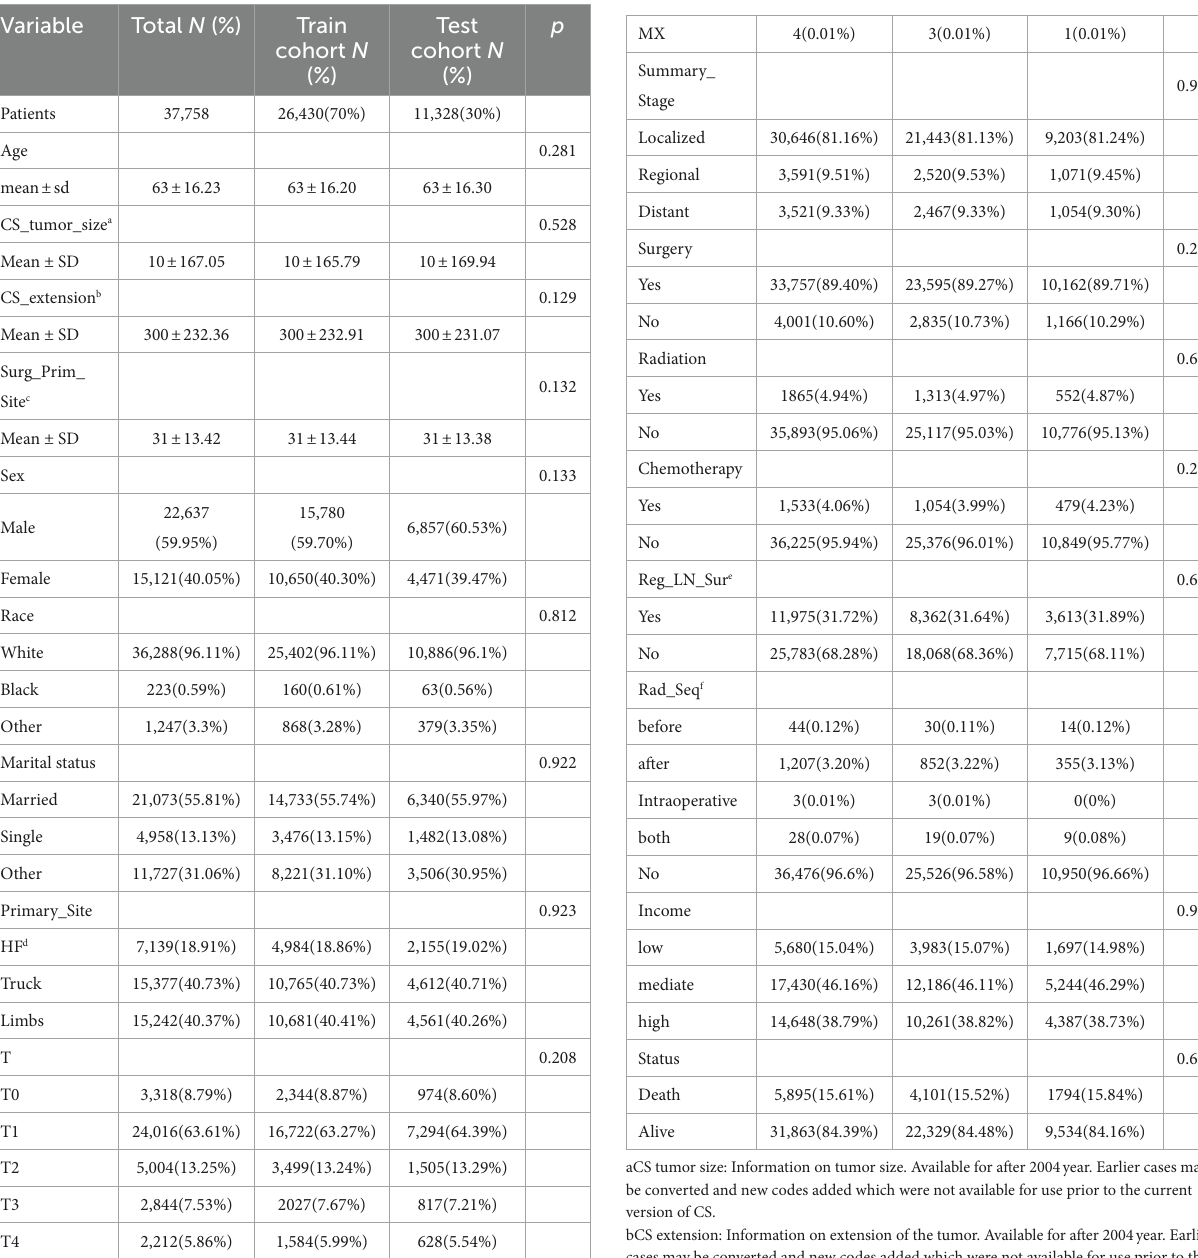
TABLE 1 Baseline characteristics of Cutaneous Malignant